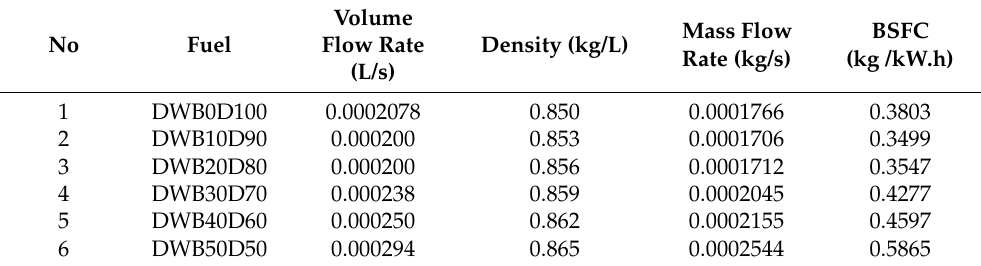
Table 6. BSFC of the engine running on blended fuels having different composition.